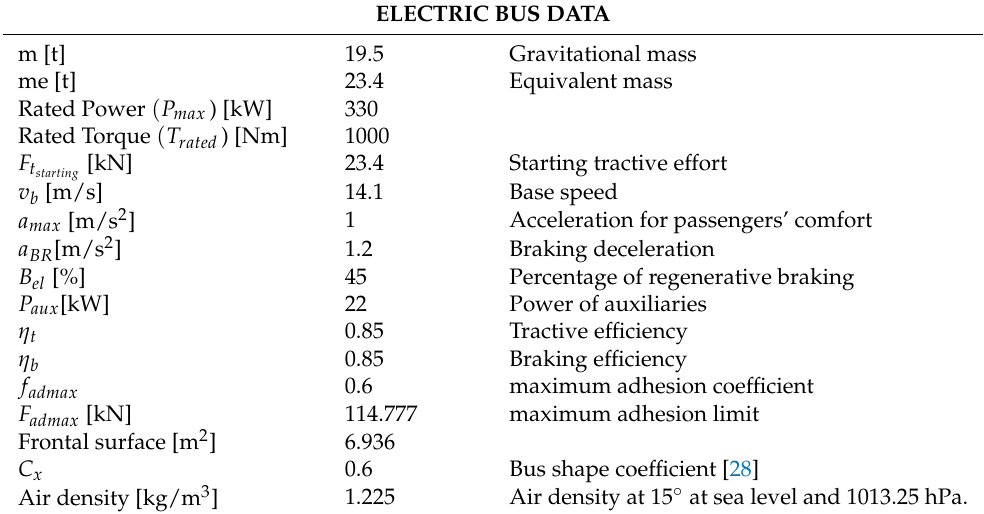
Table 2. Bus technical